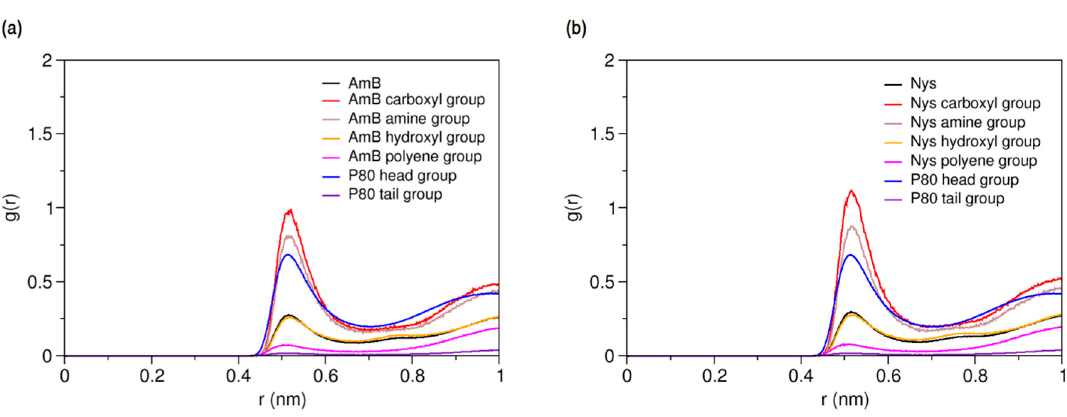
Figure 8. Average radial pair distribution functions for different molecular groups of ( a ) P80-AmB mixed micelle; and ( b ) P80-Nys mixed micelle against water particles.